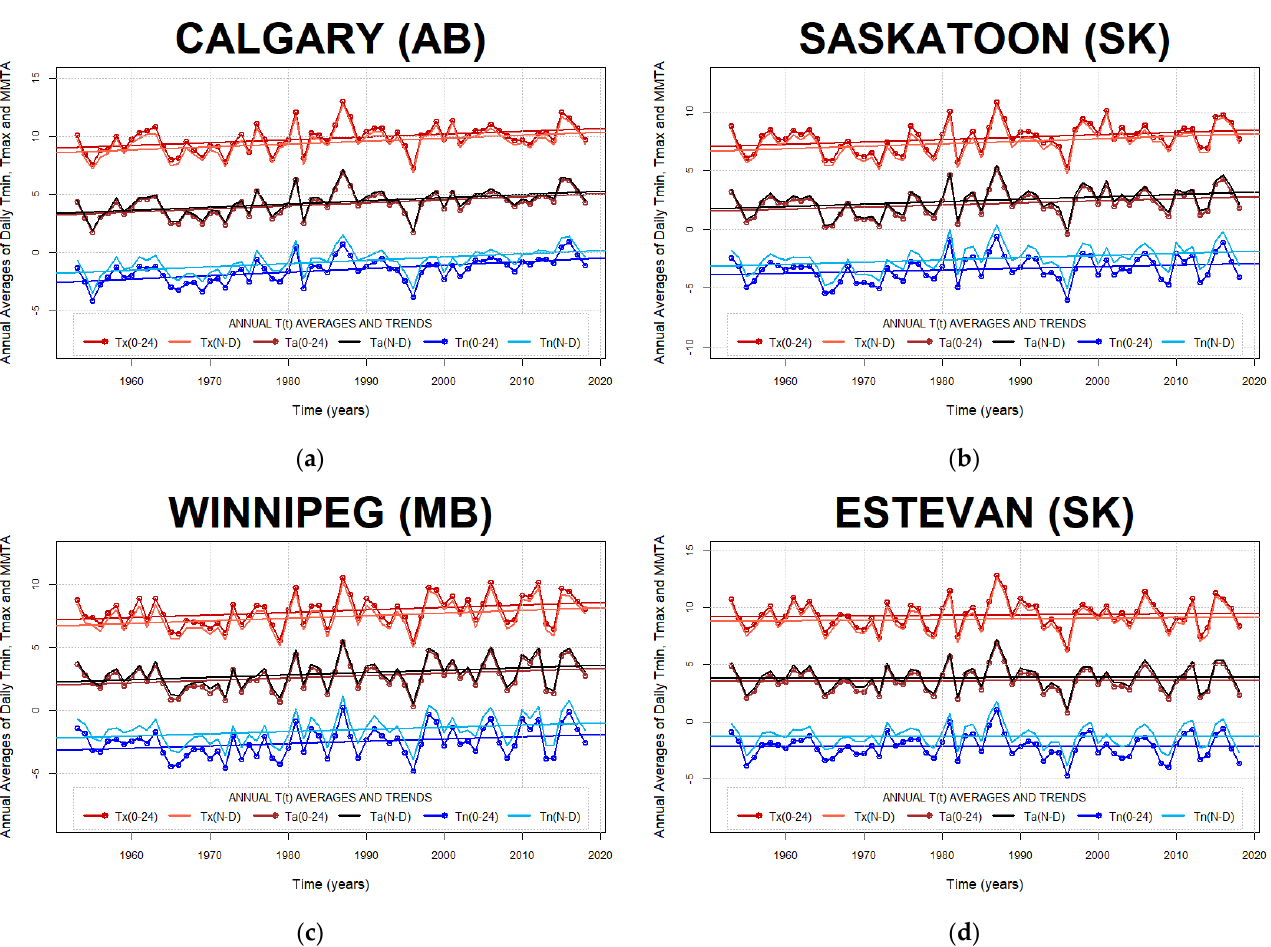
Figure A9. Prairies climate region. Effect of the observing window on long-term air temperature averaging at Calgary ( a ), Saskatoon ( b ), Winnipeg ( c ), and Estevan ( d ) stations. Annually averaged diurnal air temperature minima, maxima, and Min-Max averages obtained with COW 0–24 and COW N–D air temperature approximating methods.